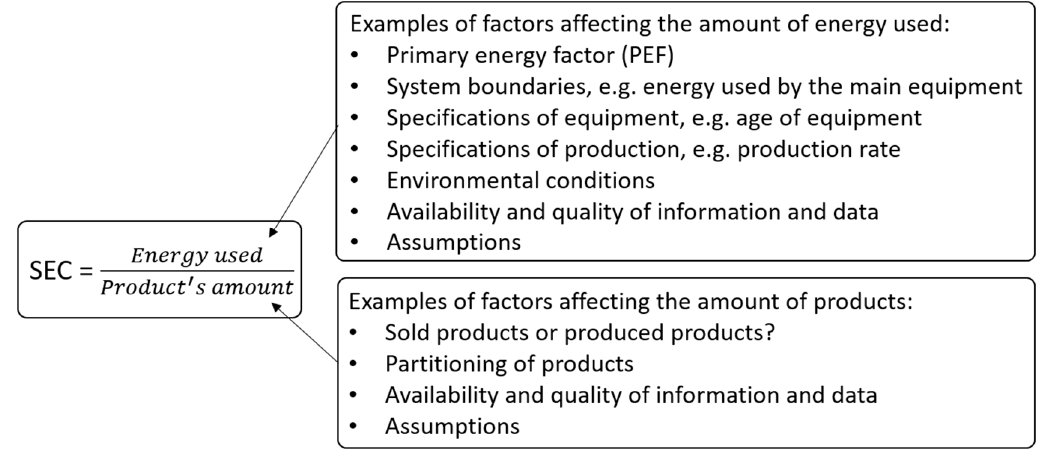
Figure 2. Examples of factors affecting the numbers for energy used and products, and therefore SEC.